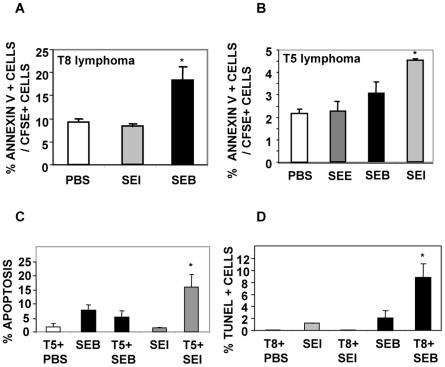
Sags increase apoptosis of cognate lymphoma T cells in vivo.(A–B) AKR/J mice were intraperitoneally inoculated with 5×106 CFSE-labeled T8 or T5 cells. One hour later 25 µg of SEE, SEI, SEB or PBS were intraperitoneally administered. After 48 hours, cells were recovered and the percentage of Annexin V+ cells/CFSE+ cells was assessed by FACS. Data are expressed as the mean ± SD, n = 4 per group. *p<0.05. (C) AKR/J mice were inoculated in the footpad with 0.3×106 T5 cells and 6 days later mice were footpad injected with 10 µg of the indicated Sag or PBS. Twenty four hours later PLN were removed and the percentage of apoptotic cells was determined by evaluating the percentage of hypodiploid nuclei by PI staining. Data are expressed as the mean ± SD, n = 4 per group. * p<0.05. (D) AKR/J mice were inoculated in the footpad with 0.3×106 T8 cells and 3 days later they were treated with 10 µg of the indicated Sag or PBS. Normal AKR/J mice were also inoculated with Sags or PBS. Twenty four hours later PLN were removed and paraffin-embedded. PLN were processed for apoptosis detection using a peroxidase-conjugated in situ TUNEL assay. Quantitative studies were performed in a blinded fashion using light microscopy on five or more fields in each sample. Original magnification ×400. Data are expressed as the mean percentage of TUNEL-positive cells ± SD, n = 4 per field. * p<0.05. All the experiments were performed three times and gave similar results.